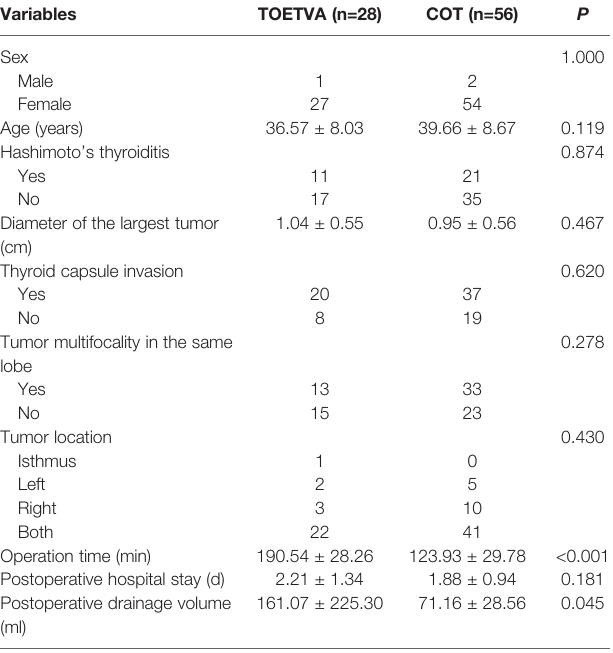
TABLE 1 | Clinical and surgical characteristics of included patients following propensity score-matching (N=84).